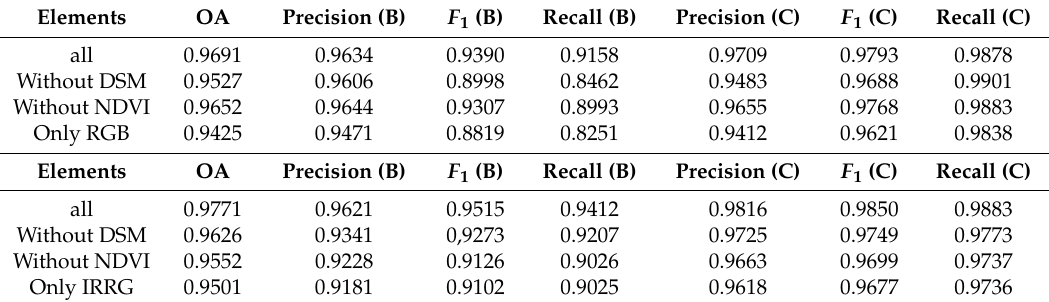
Table 2. ( a ) Compared with the results whilst exclude either the DSM or the NDVI for Potsdam dataset. ( b ) Compared with the results whilst exclude either the DSM or the NDVI for Vaihingen dataset.